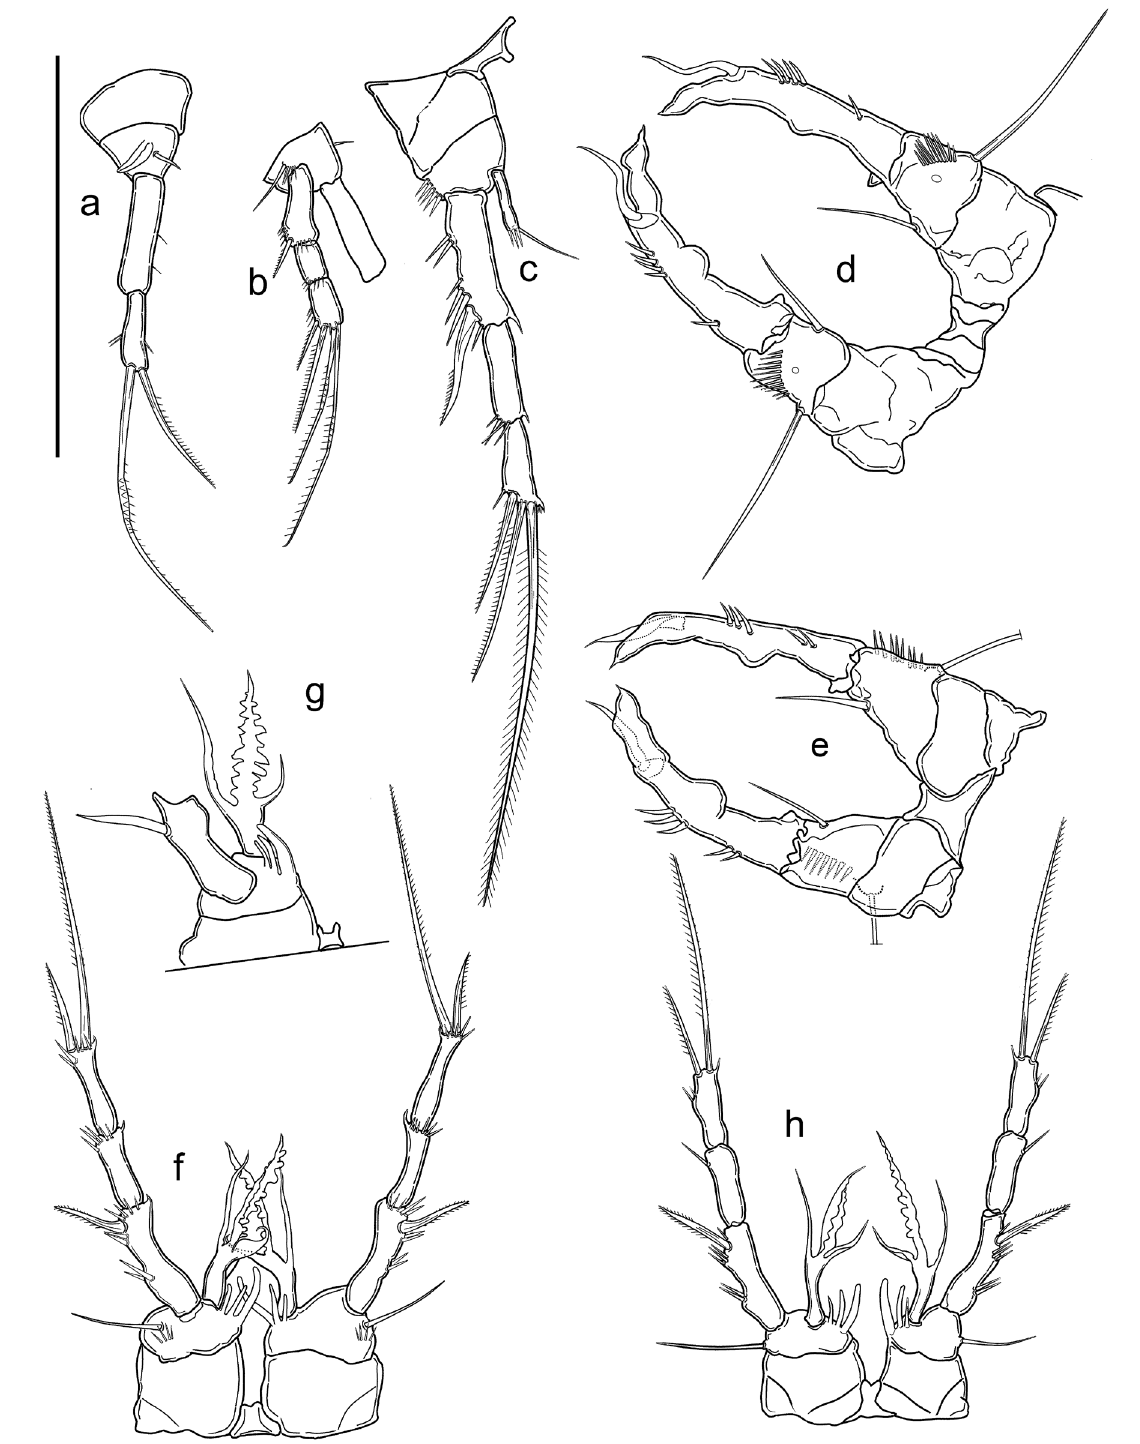
Fig. 5. Cottarellicaris sanctiangeli Bruno & Cottarelli sp. nov., ♂ (NHMUK). a . P1, coxa, basis and enp, inner view. b . P1, basis and exp, outer view. c . P2, posterior view. d . P3, anterior view. e . P3, posterior view (variability). f . P4, anterior view. g . P4, intercoxal sclerite, coxa, basis and enp, outer view. h . P4, posterior view. a, c, e, g: Grotta Vucco Ucciardo; b, h: Grotta del Banco di ferro; d, f: Grotta superiore di Sant’Angelo. Scale bar: 50